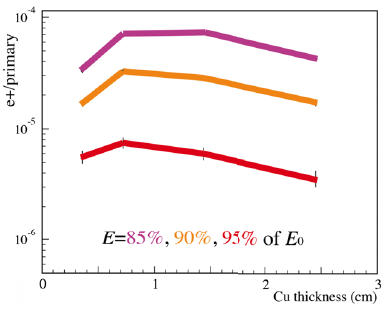
Figure 3. Positron yield as a function of the BTF target depth